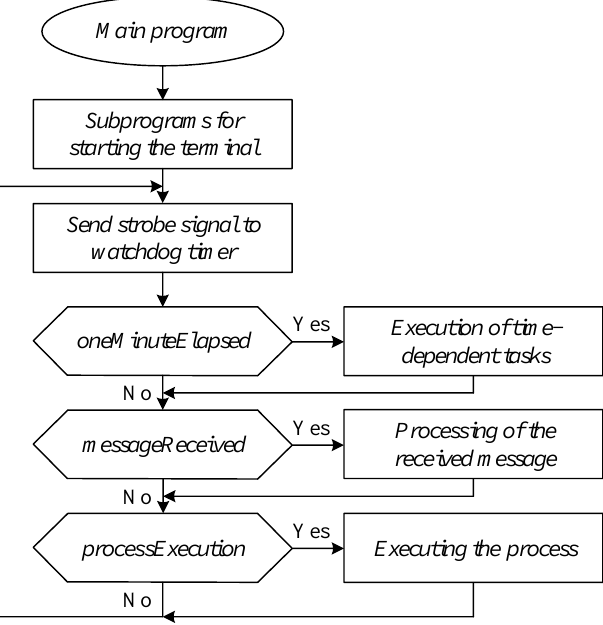
Figure 7. Main program.